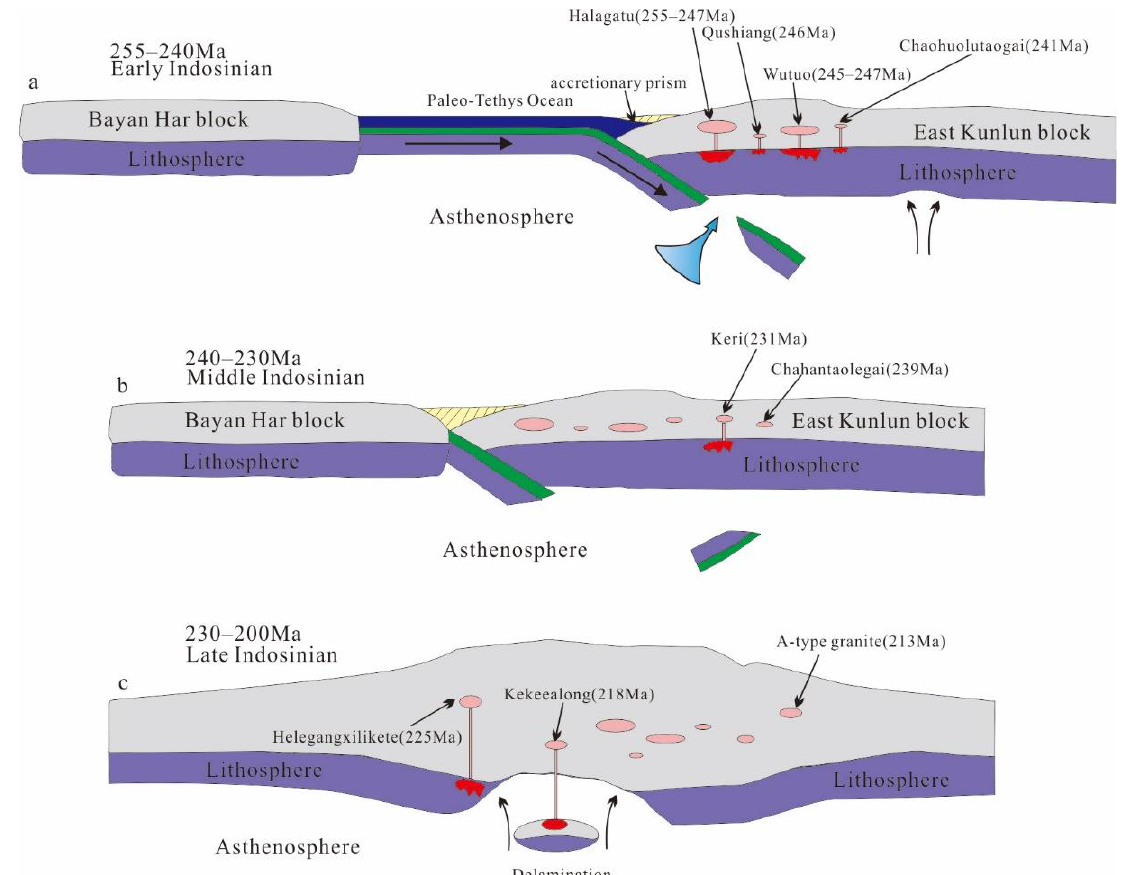
Figure 13. Diagram showing the tectonic setting of the Indosinian magmatism in the EKO. ( a ) Subduction stage: As a result of break – off of the subducted slab, the mafic magma underplated the lower crust and formed the early Triassic arc magmatic rocks in the EKO; ( b ) Collision stage: Collision between the Bayan Har block with the East Kunlun block. The granite was derived from muscovite and either biotite or hornblende during dehydration partial melting; ( c ) Post – collision: The delamination of thickened crust resulted in an extensional setting, where mafic magma underplated the lower crust to form granite.